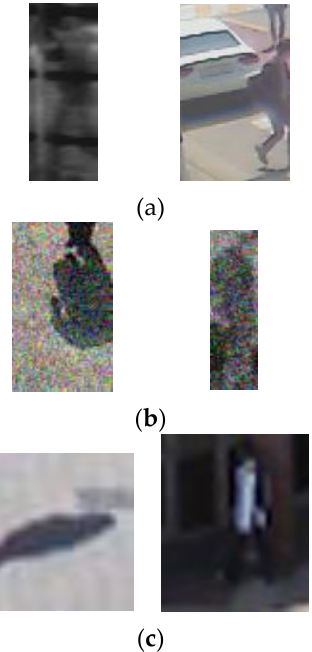
Figure 15. Examples of incorrect classification with ( a ) original DVLFPD-DB1, ( b ) degraded DVLFPD-DB1, and ( c ) OSU color-thermal database. In ( a – c ), left and right images show the FP and FN cases, respectively.